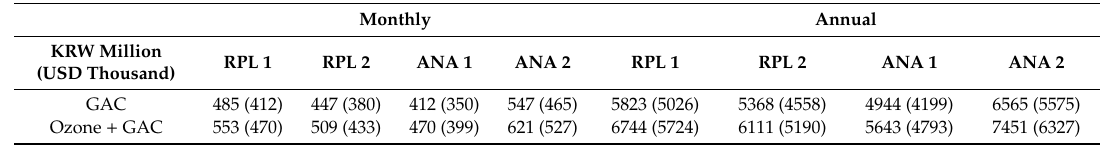
Table 7. Monthly and annual social Benefits.